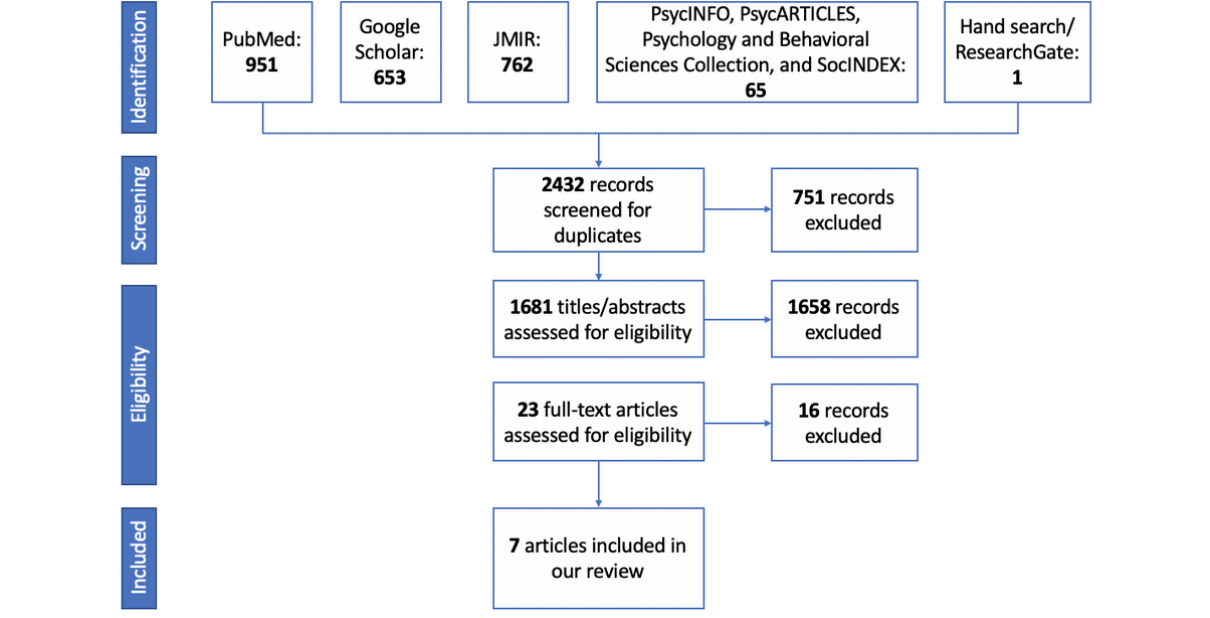
Figure 1. Flow diagram of the literature search according to the Preferred Reporting Items for Systematic Reviews and Meta-Analyses (PRISMA)